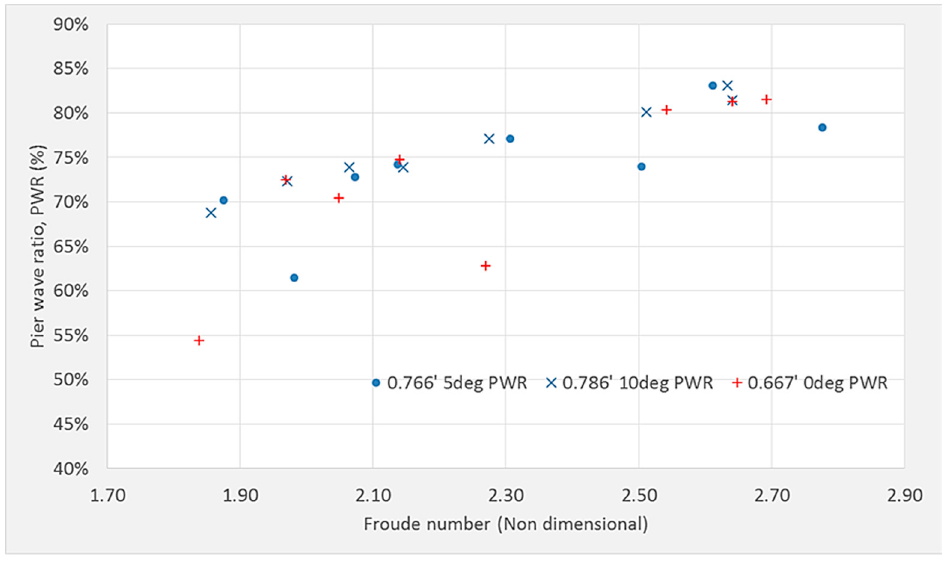
ff erent pitch angles. Fluids 2019 , 4 , x FOR PEER REVIEW